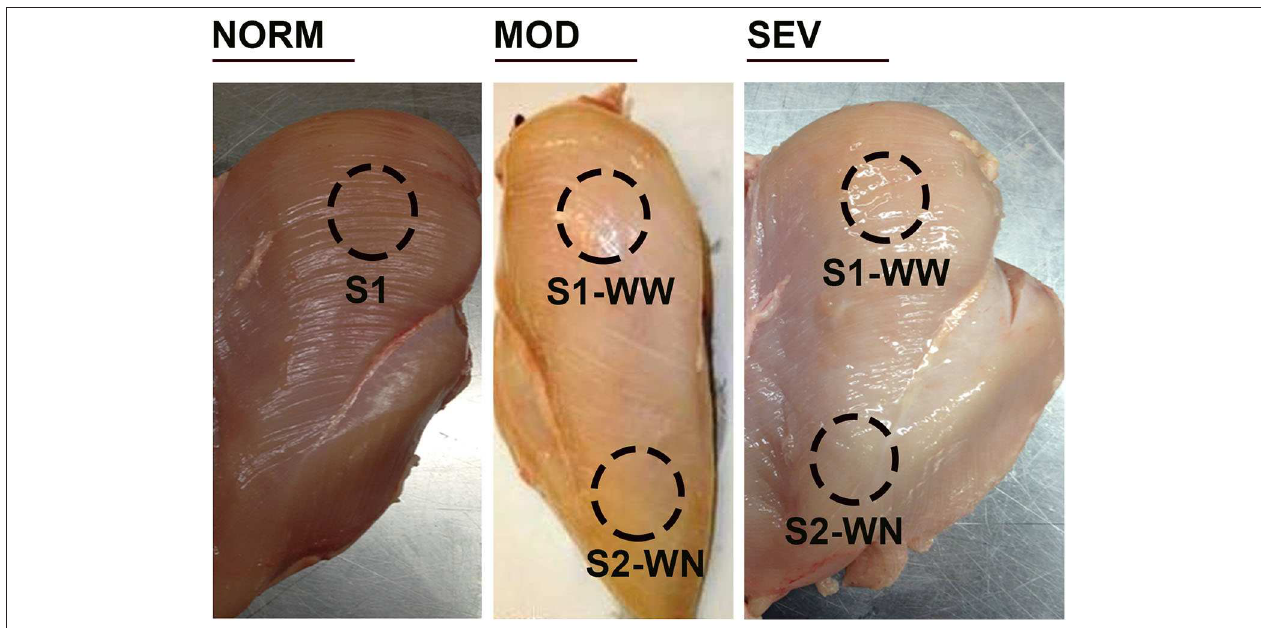
FIGURE 1 | Woody breast categories and sampling locations. Birds were processed at d56, and breast filets were macroscopically scored. NORM, normal breast without harden area; MOD, moderate woody breast with a score between 0.5 and 1.5; SEV, severe woody breast with a score between 2 and 3. S1, cranial surface; S2, caudal surface; WN, woody normal; WW, woody